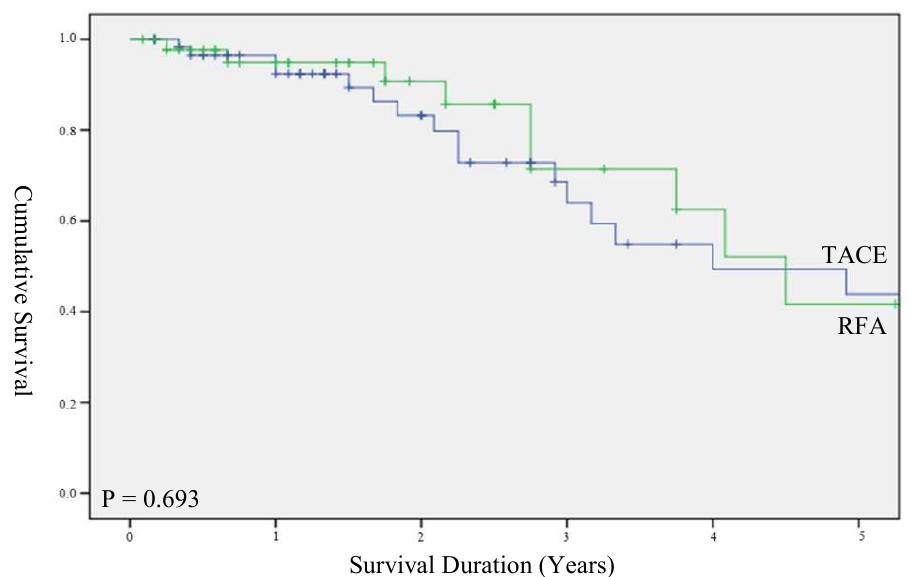
Fig. 1 Overall survival in unstratified cohort